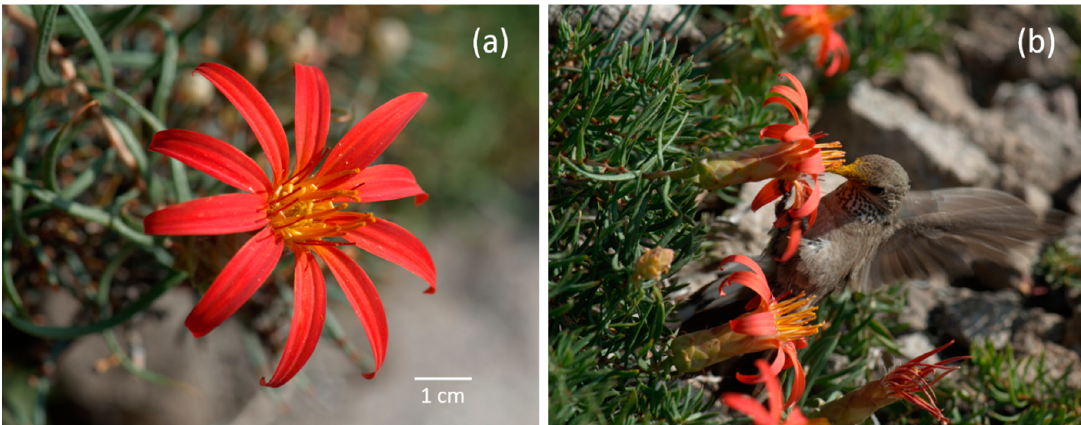
Figure 5. ( a ) Typical flower-head of M. subulata fma . rosmariniifolia (Asteraceae) showing the brilliant red ray florets, disk florets with golden-yellow corollas, dark red elongate stigmas and abundant yellow-orange pollen being extruded by the florets. ( b ) Oreotrochilus leucopleurus (White-sided